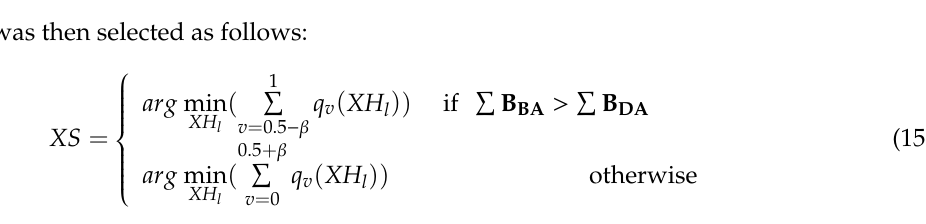
Figure 3. ( a ) Entropy curve of all bands. Image of band ( b ) 6, ( c ) 148, ( d ) 156, and ( e ) 204. ( f ) Reference